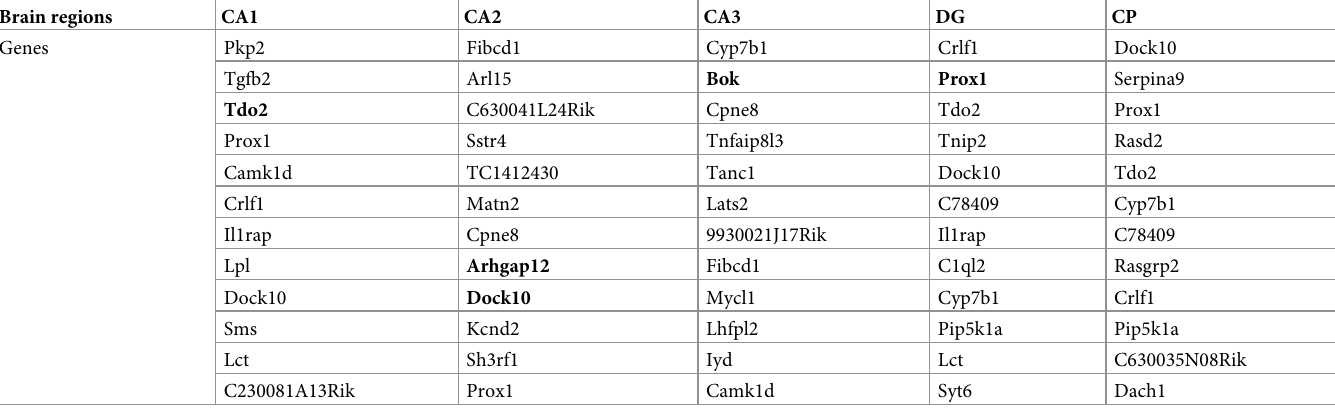
(ROC) Precision-Recall (PR) and curves. Classification was highly accurate with AUROC scores above 95% for every permutation. In order to account for the class imbalance, we also measured the AUPRC scores for CA1 (0.80), CA3 (0.78), and CP (0.74). The scores are high compared to base chance of classifying voxels in the representing feature for CA1 (0.02), CA3 (0.01), and CP (0.05). This demonstrated that an additional supervised learning step on a Table 1. 12 genes with highest weights for the overlapping SFt representation with the brain regions, with selectively expressed genes of a given brain region in bold. Brain